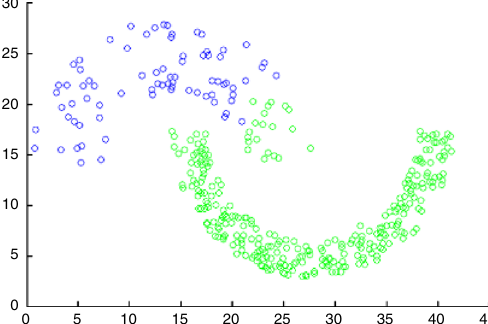
Figure 14. Result of complete-link on “ Jain ” data set